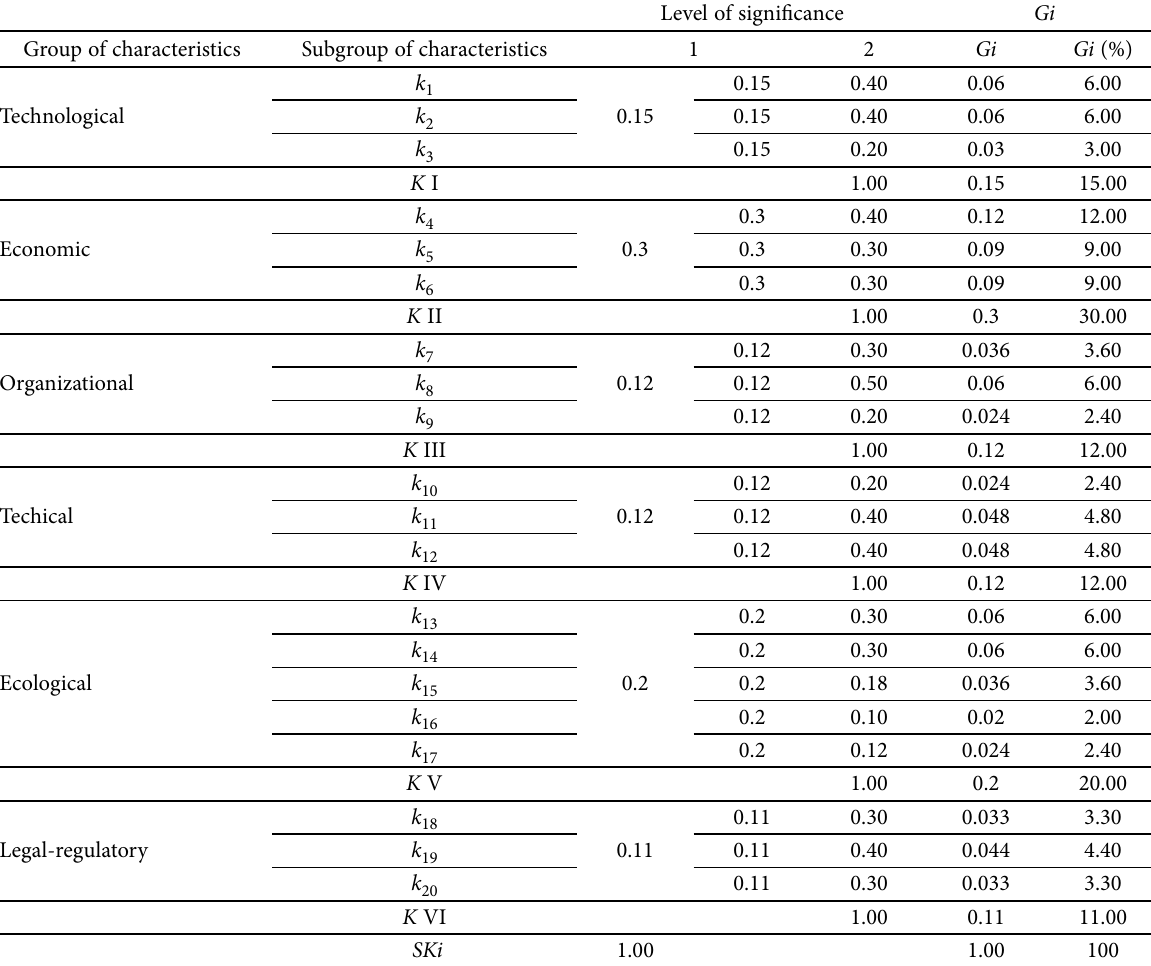
Table 2. Characteristics of the attributes and relative